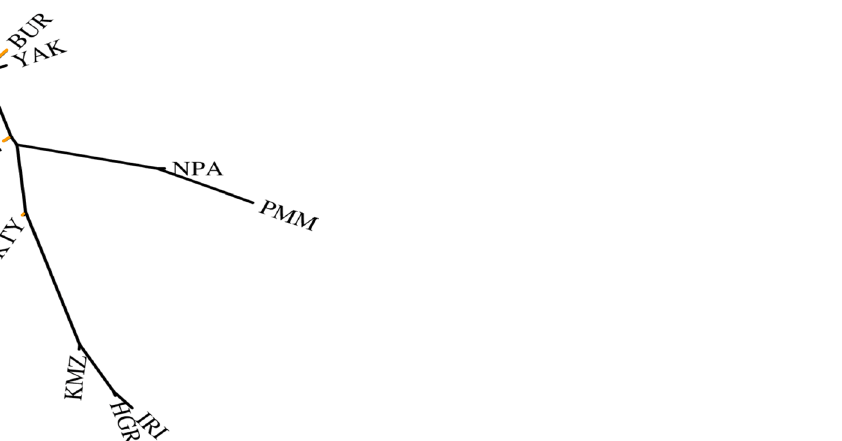
Figure 9. Best exact Least Squares tree for 15 populations. Negative branches to the Buryat, Altai Kazakhs, and Khanty are